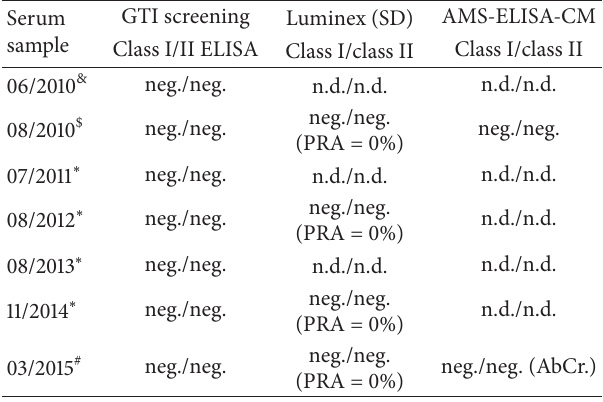
Table 2: Results of different antibody detection and specification analyses in comparison with crossmatch-ELISA outcomes all of which exclude an involvement of anti-HLA DSA in a rejection episode of the 48-year-old heart recipient with high